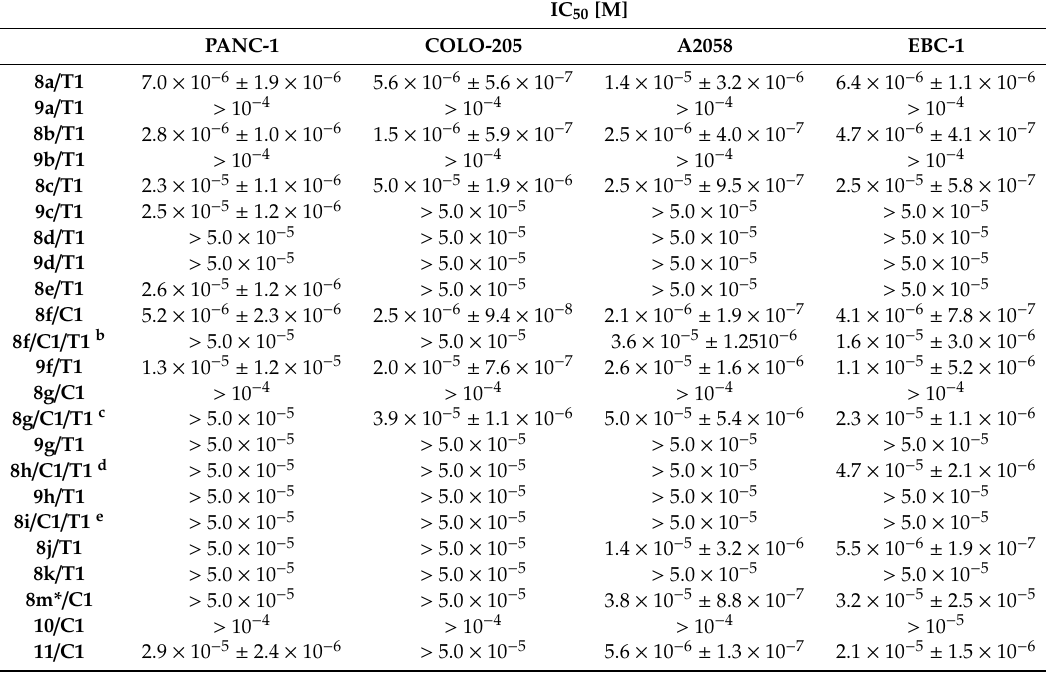
Table 4. In vitro cytotoxic e ff ect of novel polycondensed β -carbolines types 8–11 a , on four human malignant cell lines characterised by half-maximal inhibitory concentration (IC 50 )